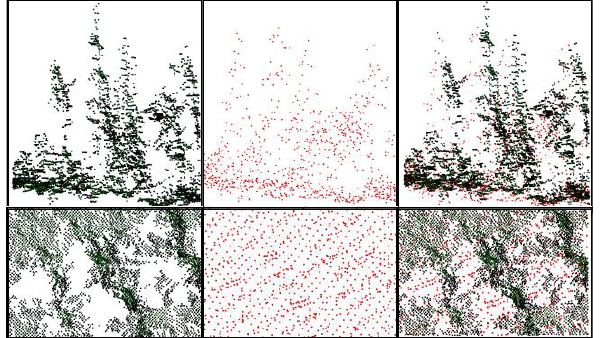
Figure 1. From left to right, virtual views of photogrammetric point clouds (dark colored points), lidar (red points) and both of a balsam fir stand (horizontal view in the first row, vertical view in the bottom